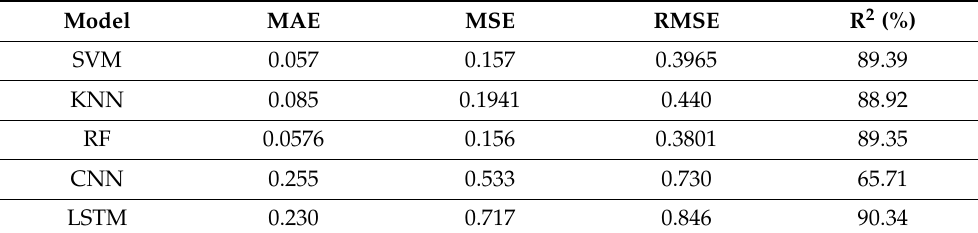
Prediction results of machine learning and deep learning model using a multi- classification dataset.